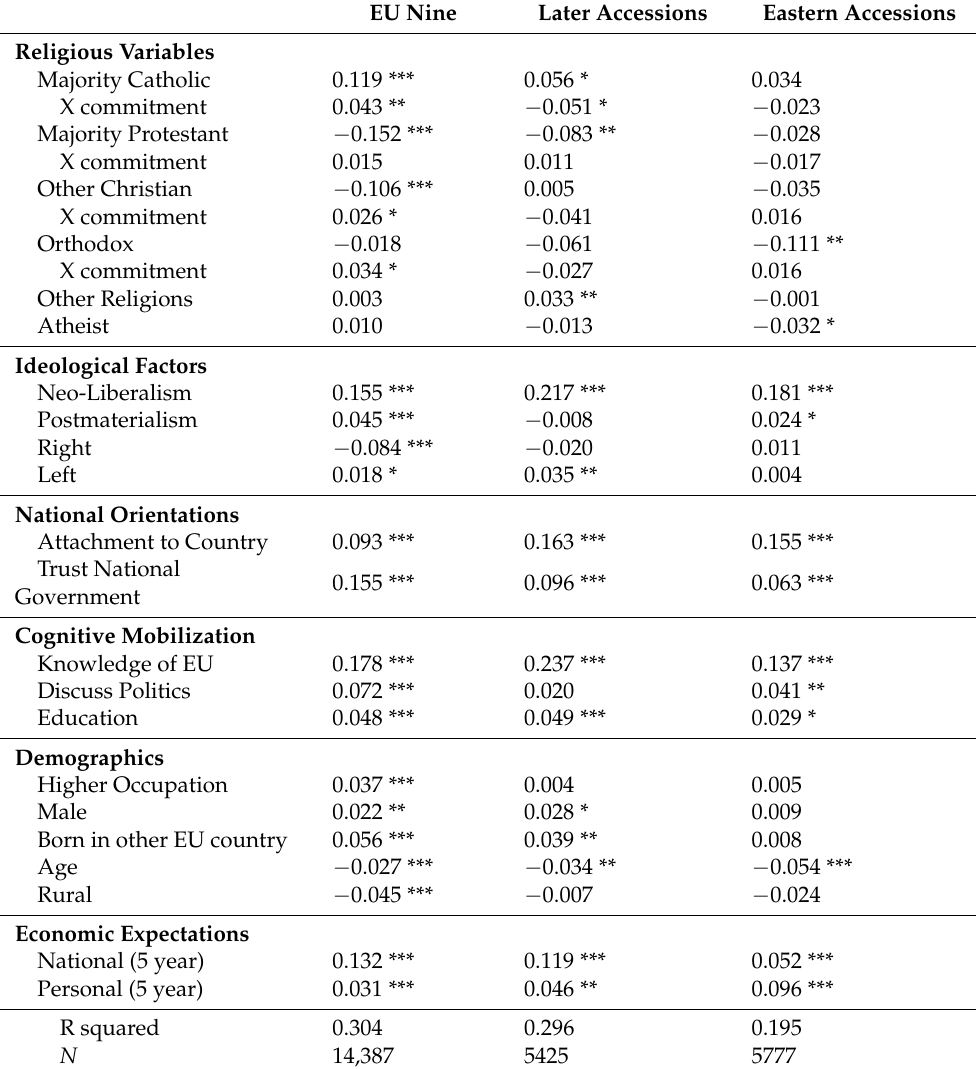
Table 5. European Identity: OLS betas for EU Nine, Later and Eastern Accessions. EU Nine Later Accessions Eastern